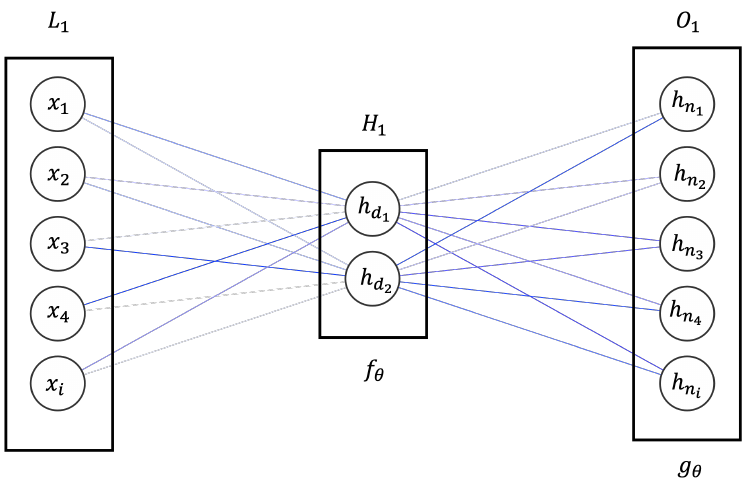
Figure 4. Graphical representation of an